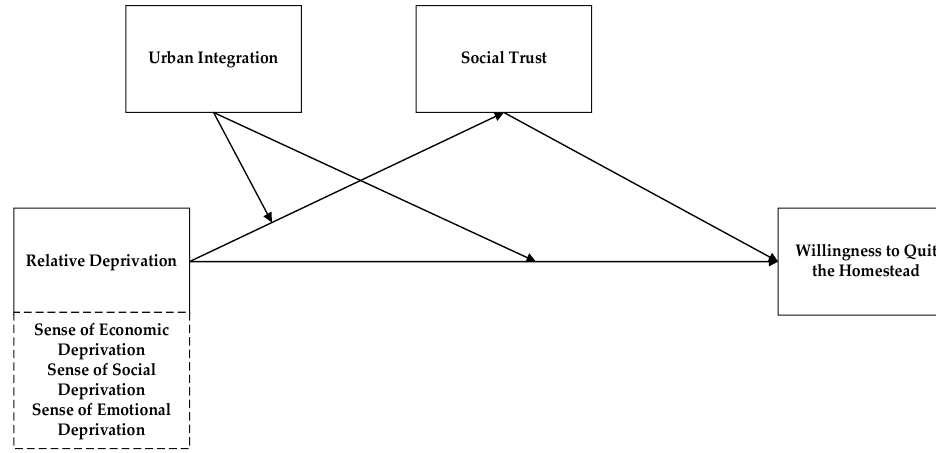
Figure 1. Theoretical framework of the